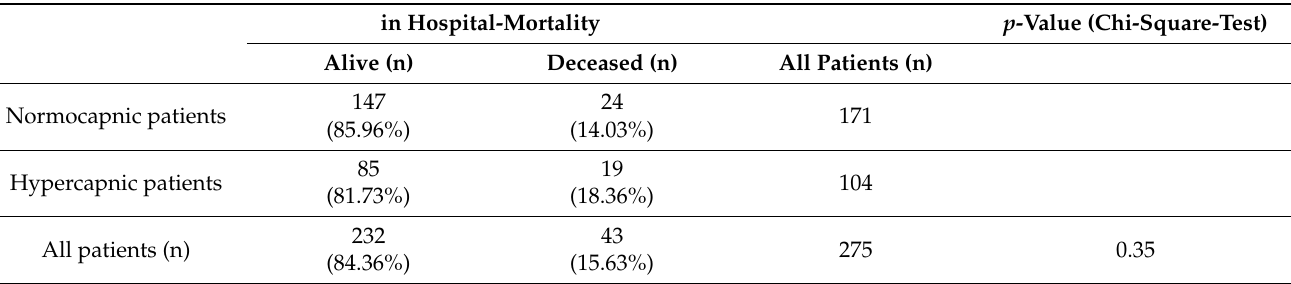
Table 2. In-hospital mortality in normocapnic and hypercapnic